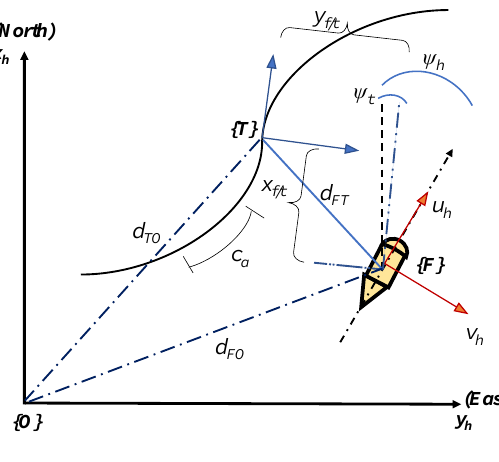
Figure 3. Controller Configuration in 3D Plane.